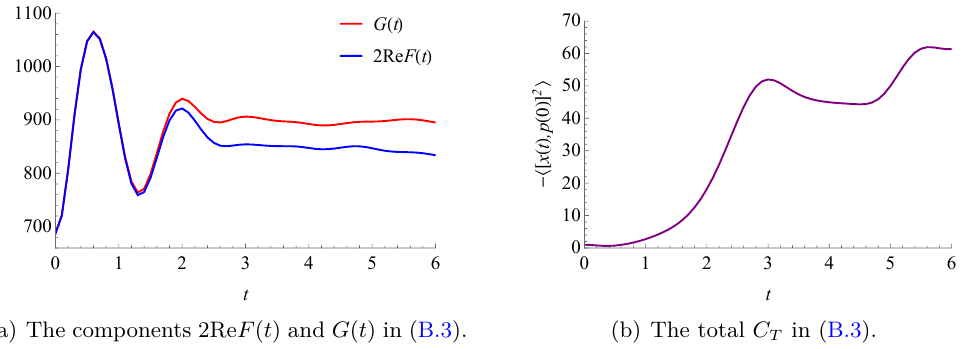
Figure 13 . Time evolution of the thermal OTOC at T = 30